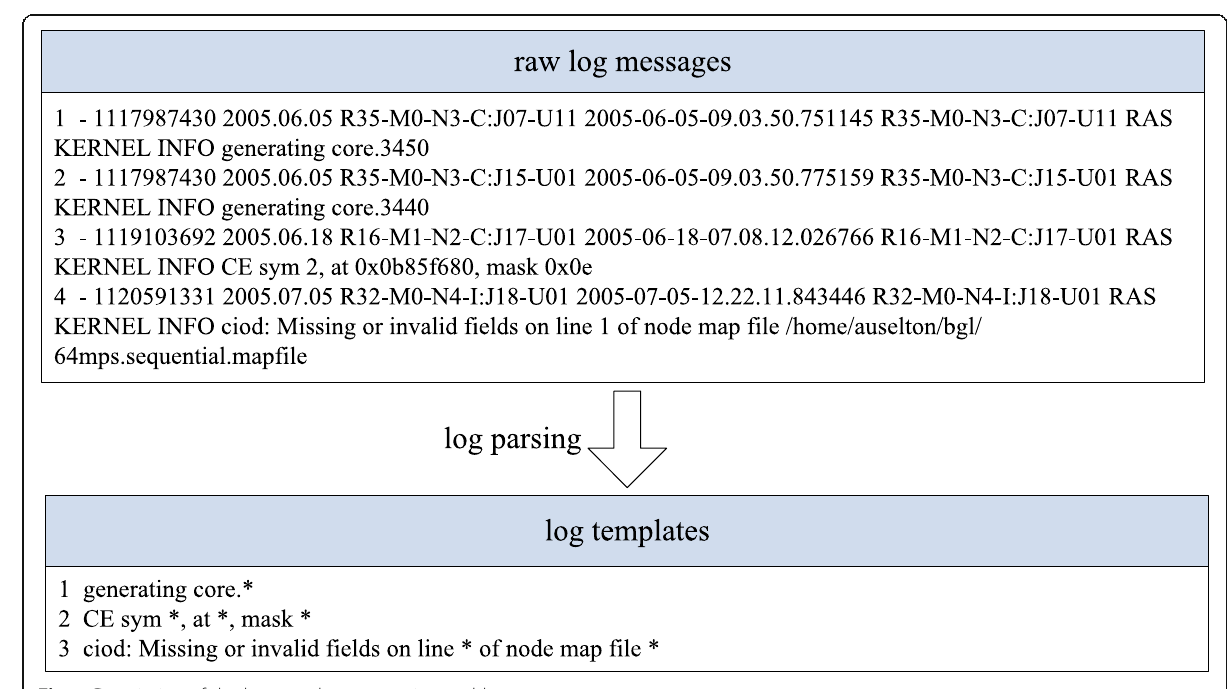
Fig. 1 Description of the log templates extraction